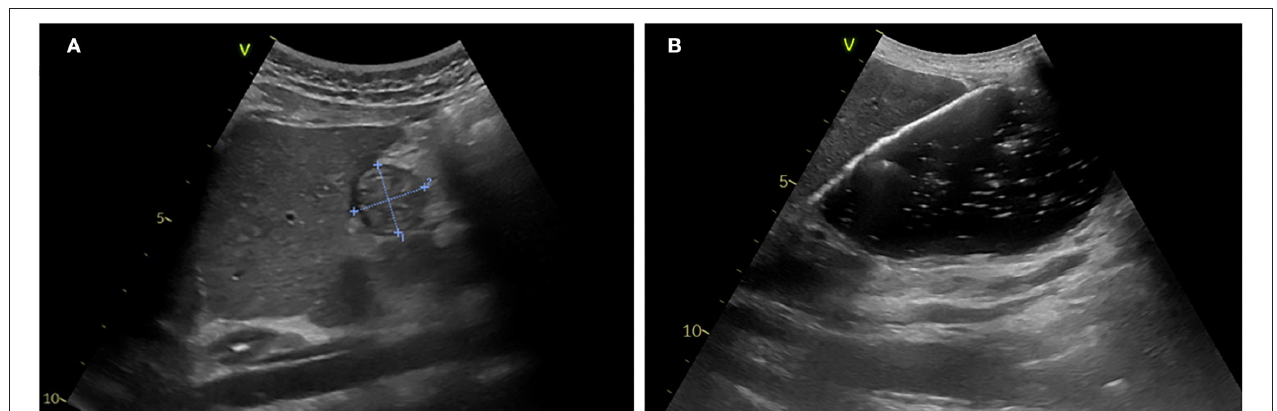
FIGURE 3 | Gastric POCUS to assess gastric volume and content. (A) Empty stomach. (B) Full stomach (liquid content). Curvilinear low-frequency (2–5 MHz) or high-frequency linear transducers were used for examination (the former providing better scanning in older children). The gastric antrum was scanned in the epigastric sagittal plane, in the supine and/or in the right lateral decubitus position, for qualitative assessment and/or for the measurement of the antral cross-sectional area. In some studies, a longitudinal scan of the stomach was performed, allowing measurement of 3 diameters (anteroposterior, transverse, and longitudinal axes) for the calculation of the spheroid stomach volume (43, 44, 46). Repeated measurements minimize intra-rater variability. Gastric content volume was calculated in four studies using the mathematical model by (52) ( R ² = 0.60), and in one study, it was calculated using the mathematical model by Schmitz et al. (7) ( R ² = 0.582).